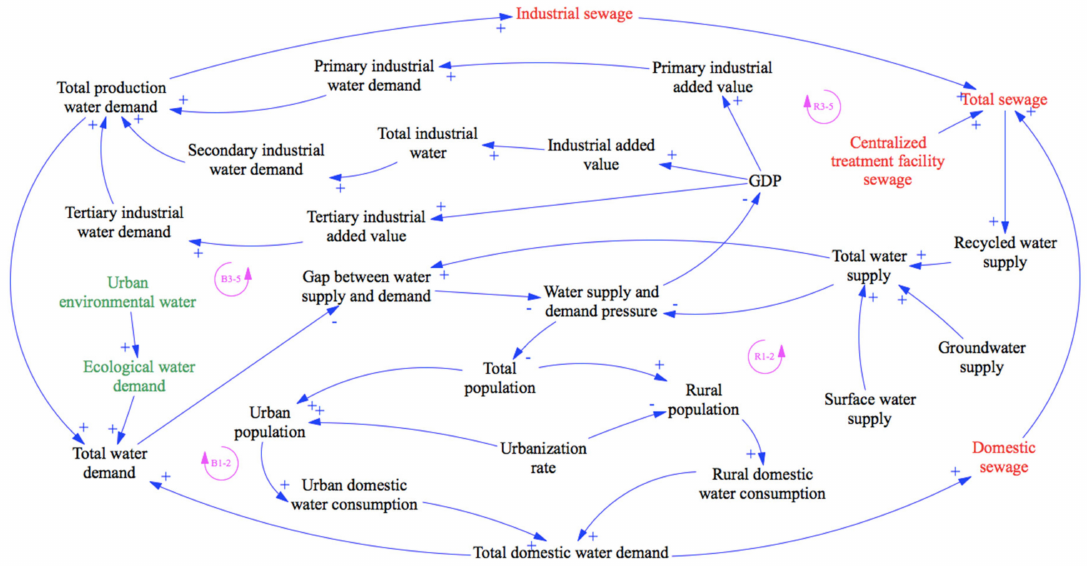
Figure 3. Water subsystem causal loop diagram.